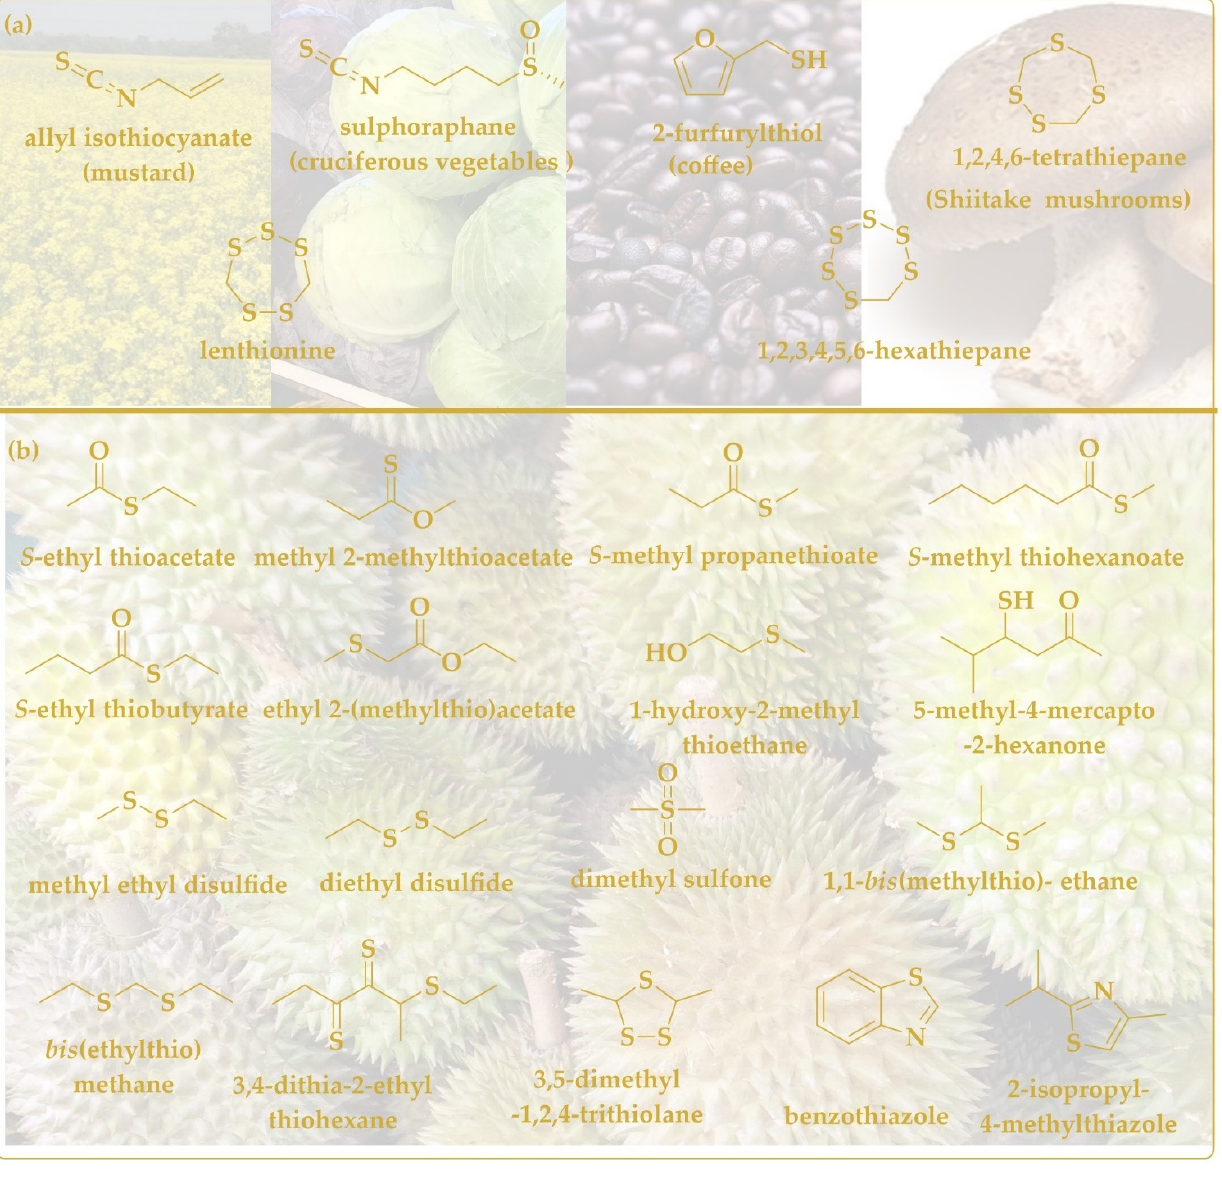
Figure 5. A brief overview of volatile sulfur species found in natural products such as mustard, cruciferous vegetables, coffee, and shiitake mushroom ( a ), and in durian fruit ( b